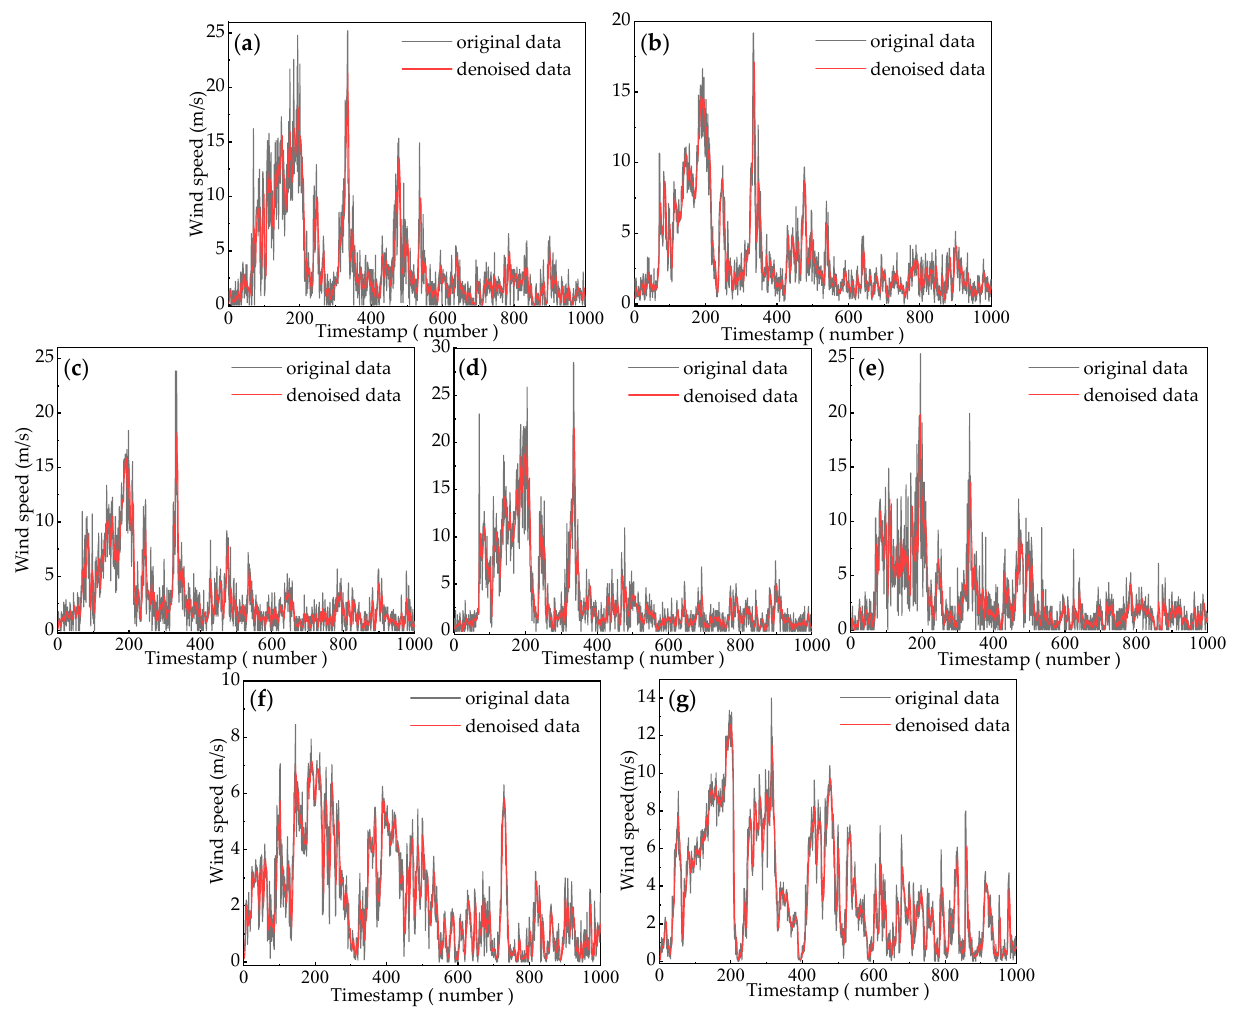
Figure 6. Data preprocessing on the historical wind speed sequences of seven selected wind farms: ( a ) Site#1, ( b ) Site#2, ( c ) Site#3, ( d ) Site#4, ( e ) Site#5, ( f ) Site#6, ( g ) Site#7. Four indices, the root mean squared error (RMSE), mean absolute error (MAE), mean absolute percentage error (MAPE) and R-squared (R 2 ), are used for evaluation [28,35]. Their definitions are available